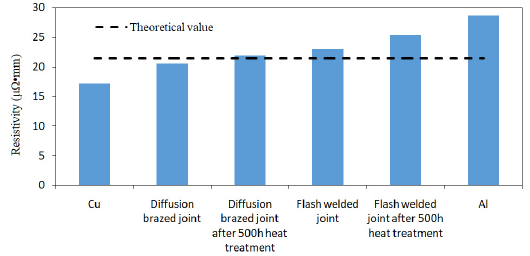
Figure 11. The electrical resistivity of Cu/Al joints and base